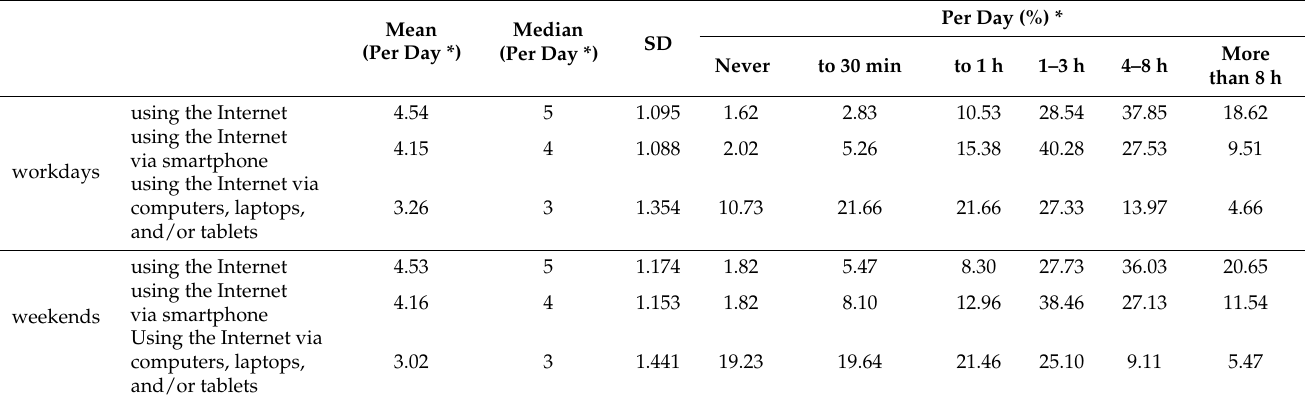
Table 1. Daily Internet use during workdays and weekends, via smartphone and via other devices. Mean (Per Day